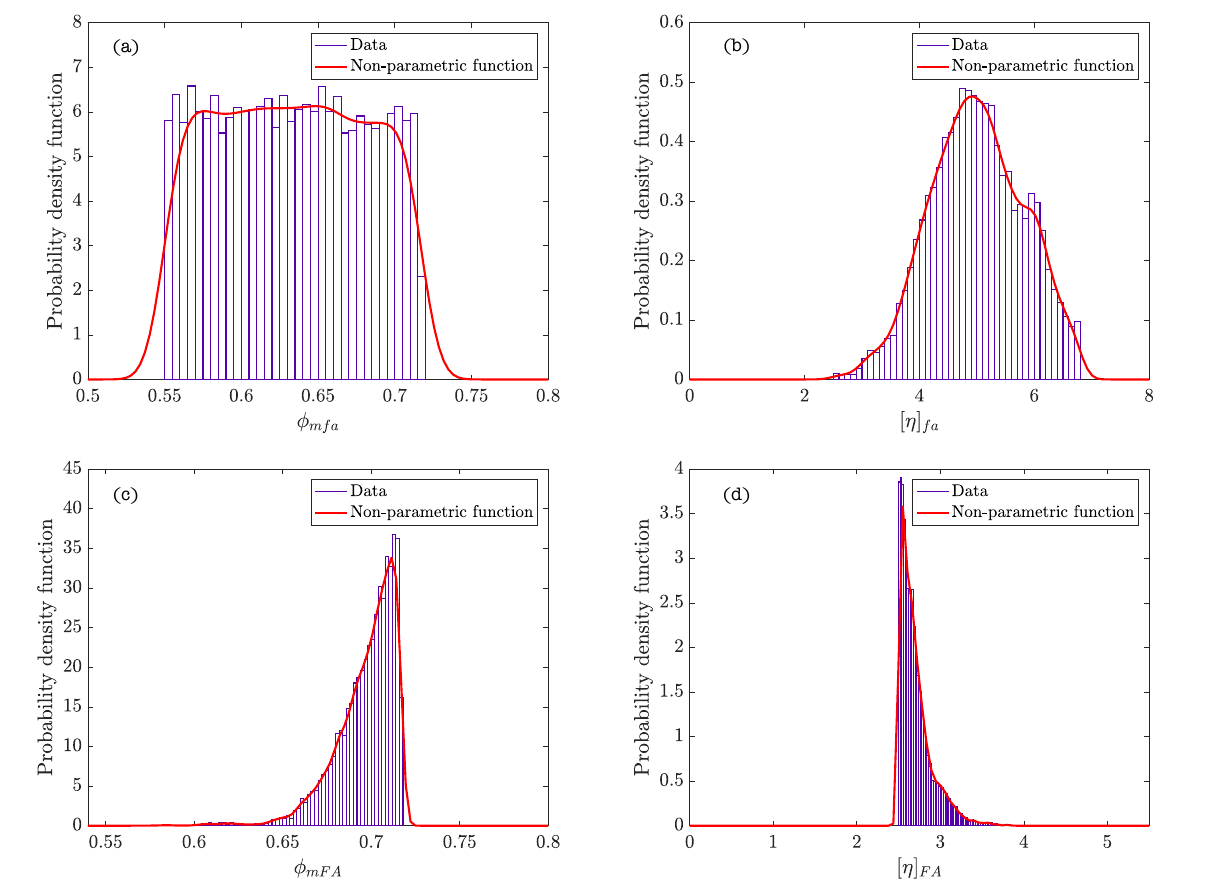
Figure 3. Probability density functions of φ m and [ η ] for the powder phase (( a , b ), respectively), and fine granular phase (( c , d ), respectively) in SCSFRC ( λ